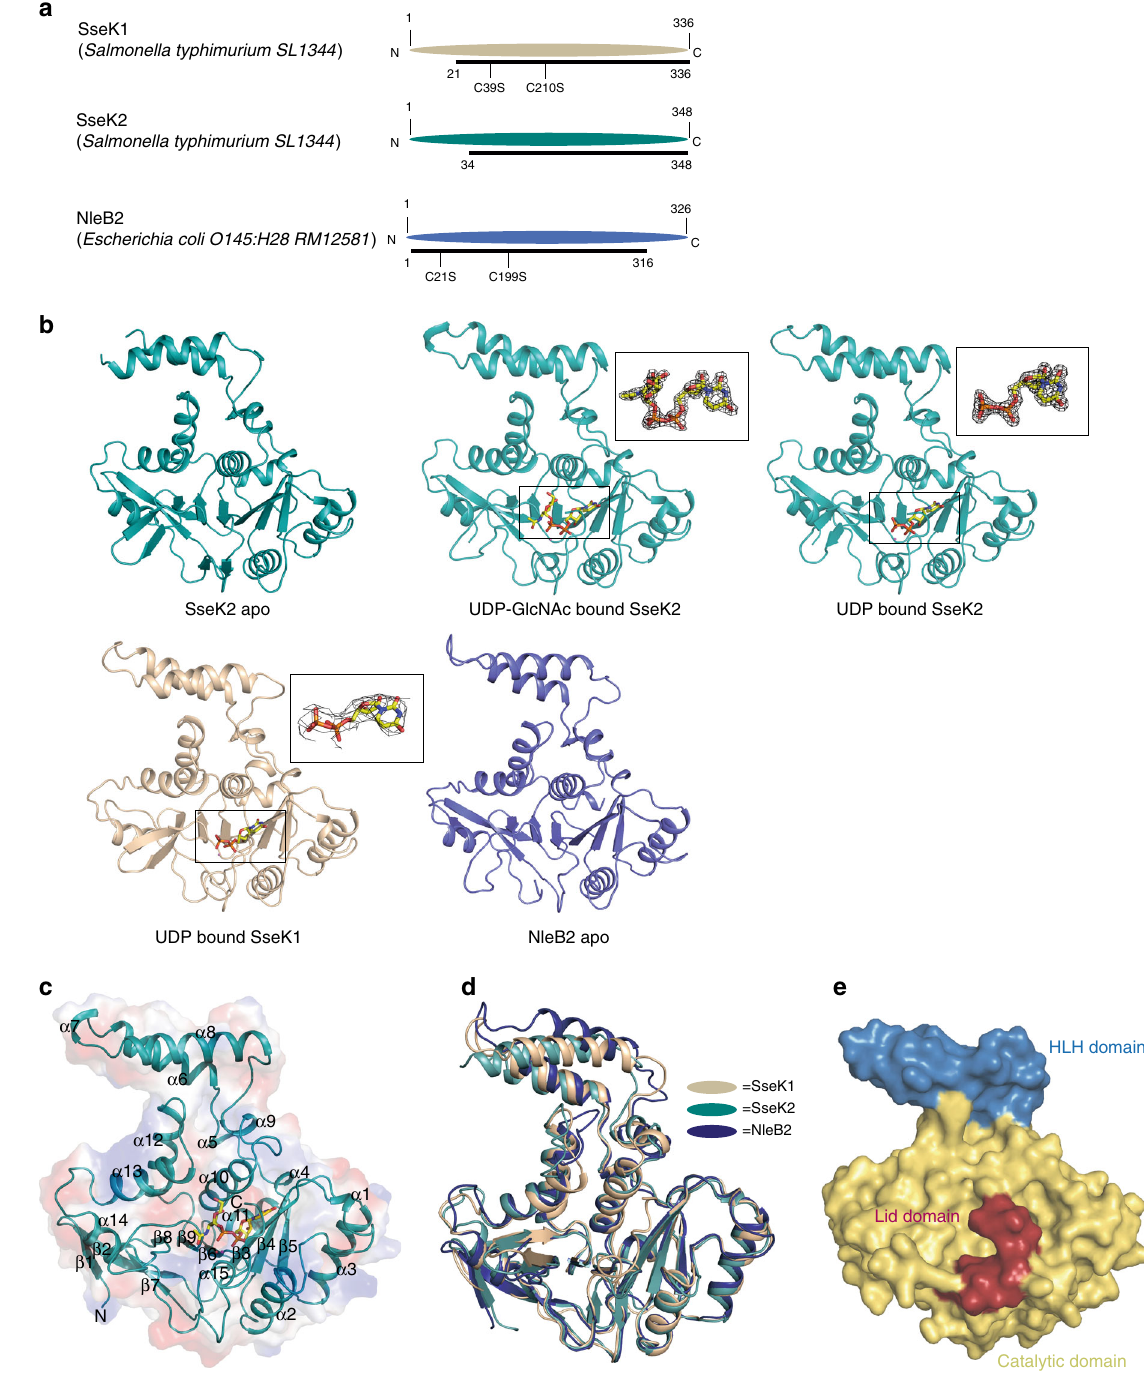
Fig. 2 Overall enzyme architecture. a Colored ovals show the full-length amino acid sequence and the black line under the oval shows the amino acid sequence used for overexpression and crystallization. b Arrange crystal structure and electron density maps of each ligands (2Fo – Fc electron density maps of UDP on SseK1 and UDP & L-arginine on SseK2 contoured at 1 σ and UDP and the others are 2 σ ). c Numbering of the α -helices and β -strands of SseK2 and d superimposition of SseK1, SseK2, and NleB2. e Each sub-domain is presented in different colors (blue: HLH domain, yellow: catalytic domain, red: lid